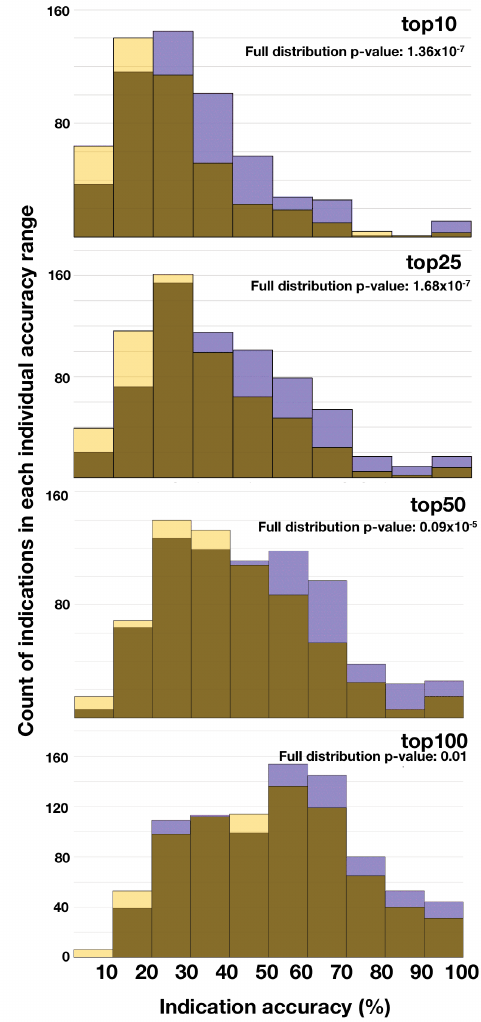
Figure 5. Frequency comparison of indication accuracies for two CANDO platform pipelines at different cutoffs. Shown are four histograms denoting the frequency with which indications fall within particular accuracy ranges (Vina-134 pipeline accuracies are in light yellow and v1.5 accuracies in black). The similarity of each distribution is assessed by the p -value using the Kolmogorov– Smirnoff test ( p -values less than 0.05 are considered to be significant). The v1.5 pipeline outperforms Vina-134 overall, but the p -values indicate that the accuracy distributions are different for the two pipelines, indicating the utility of combining pipelines to produce synergistic